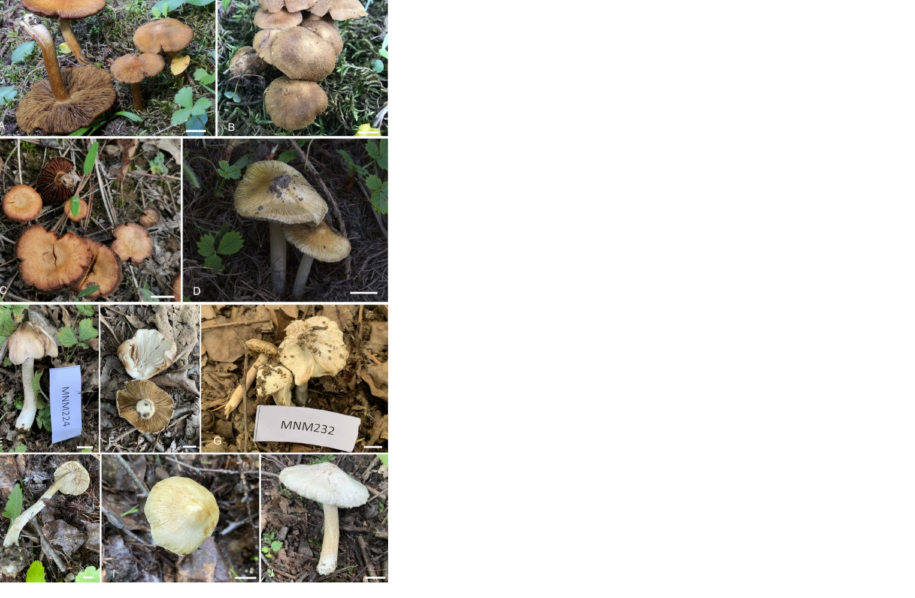
Figure 3. Basidiomata of Mallocybe and Pseudosperma . ( A , B ). Mallocybe picea (BJTC FM555, holotype), ( C ) Mallocybe depressa (BJTC C643), ( D ) Pseudosperma laricis (BJTC FM887, holotype), ( E – G ) Pseu- dosperma pseudoniveivelatum (BJTC FM1660, holotype), ( H – J ). Pseudosperma gilvum (BJTC FM1941, holotype). Scale bars: ( A – J ) = 10 mm.